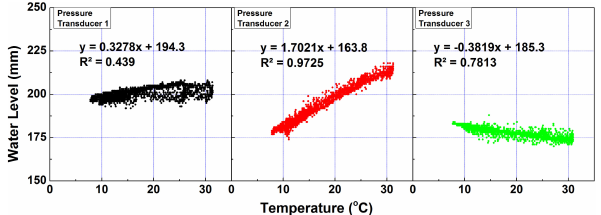
Figure 3. Relationships between temperature and water level read-